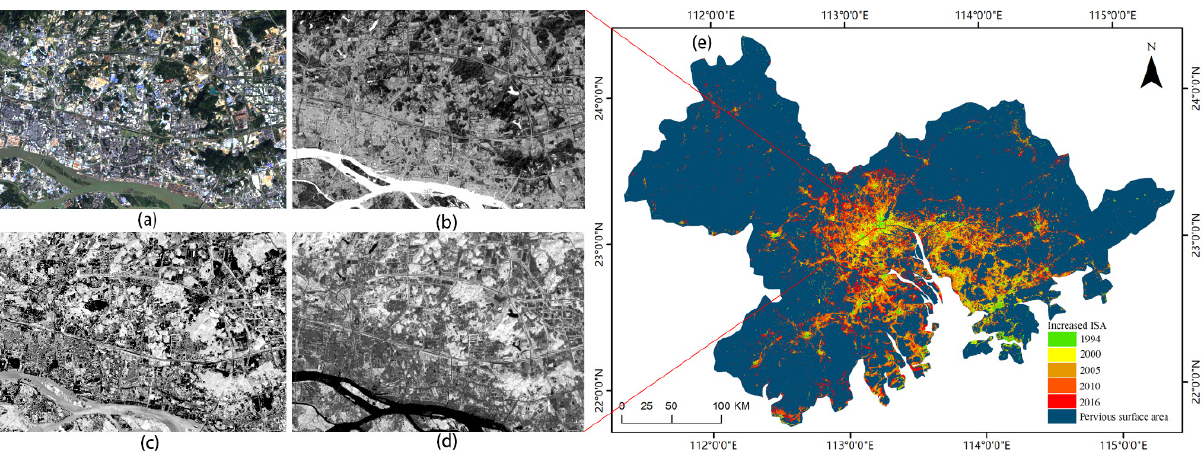
Figure 6. ( a ) True-color Landsat 8 OLI imagery; ( b ) the combinational biophysical composition index (CBCI) image; ( c ) the modified bare soil index (MBSI) image; ( d ) the optimized soil adjusted vegetation index (OSAVI) image, and ( e ) the dynamic changes in the ISA in the GHM Bay Area from 1994 to 2016.